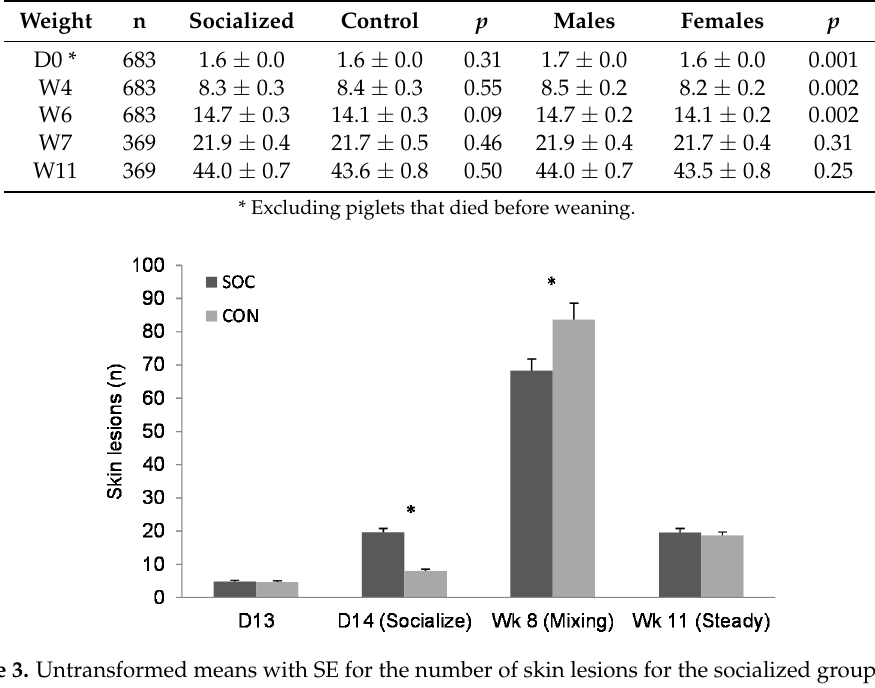
Table 3. LSMeans with SE and p -value for body weight of socialized and control piglets and for males and females.